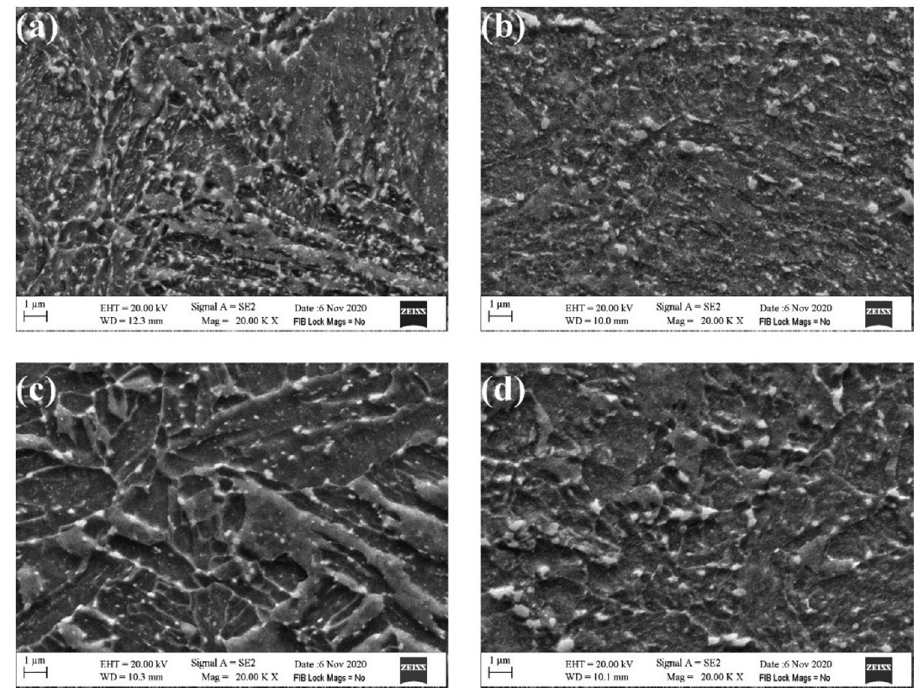
Figure 6: The tempered microstructure of the two steels by SEM at 650°C for di ff erent tempering time: ( a ) 2 h - 5CrNiMoV, ( b ) 2 h - 5CrNiMoVNb, ( c ) 24 h - 5CrNiMoV, and ( d ) 24 h -